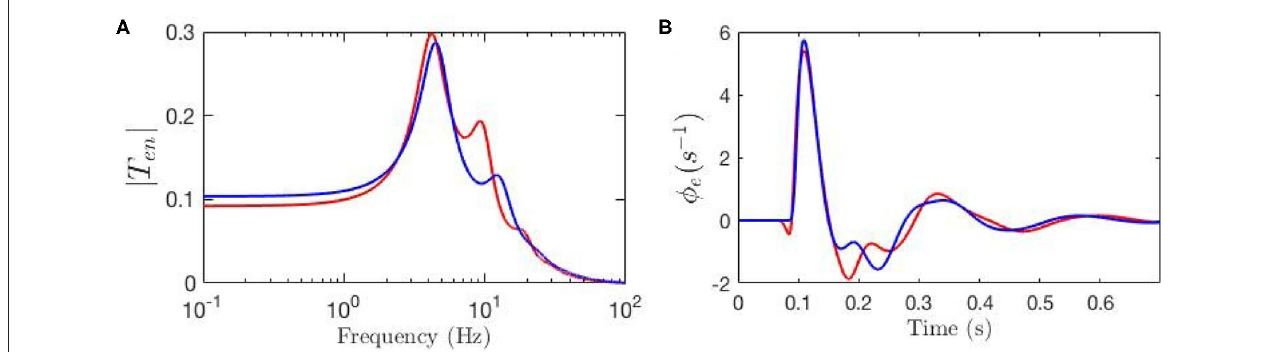
FIGURE 6 | Transfer functions and corresponding ERPs for parameters fitted by Kerr et al. (2011), as listed in Table 1 , and represented by blue line, and for modulated gain parameters represented by red line. (A) Magnitude of the transfer functions. (B) Model cortical ERPs.